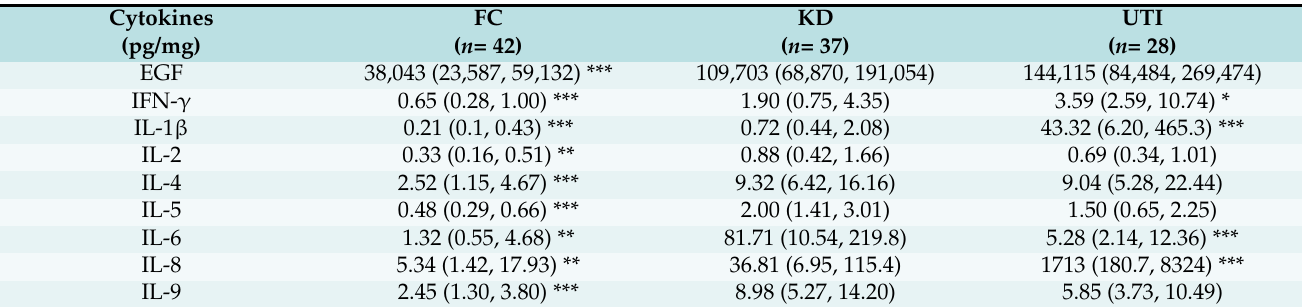
Table 2. Differences in urinary cytokines between fever-control, Kawasaki disease, and urinary tract infection groups.